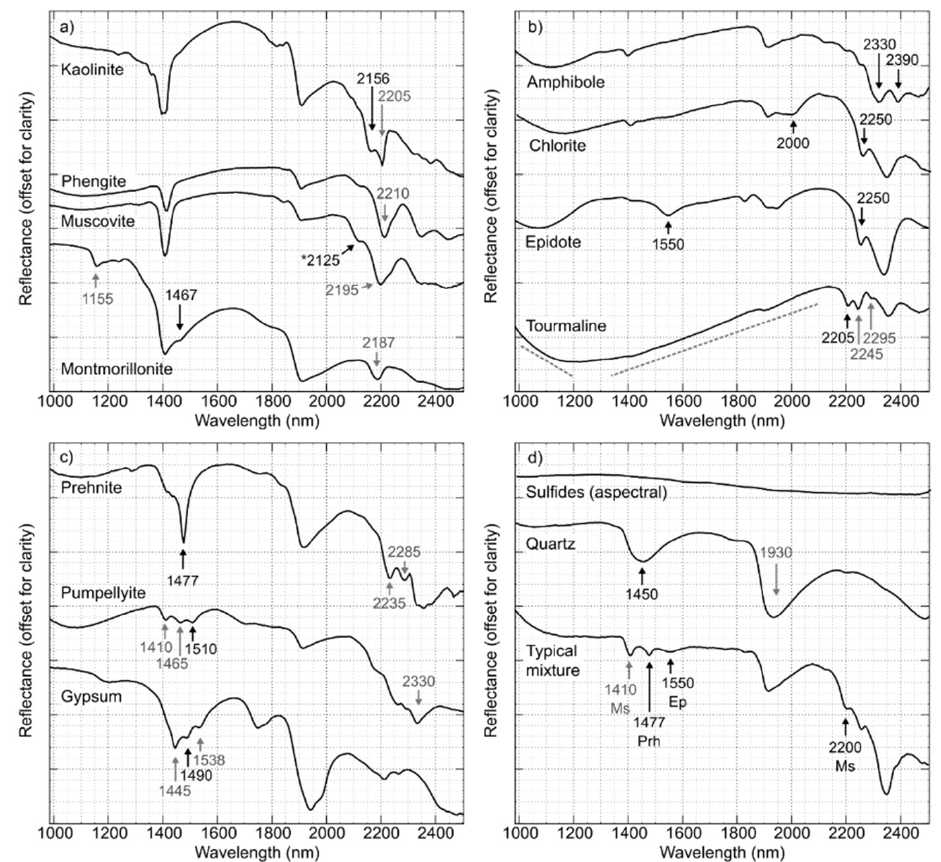
Figure 2. Mineral spectra derived from the sample suite, in all cases obtained from 3 × 3 pixel averages. Absorptions used for identifications are indicated with black arrows, and additional distinctive absorptions (not used here) are indicated in grey. Dashed lines indicate regions where minerals are identified using the slope of the spectrum (band ratios). Spectra are offset and scaled for clarity but are not continuum removed. ( a ) Spectra of Al-bearing phyllosilicates. Note that the 2125 nm absorption of white mica is only detectable in coarse-grained samples. ( b ) Spectra of (Fe, Mg)-bearing minerals. ( c ) Spectra of Ca-bearing minerals. ( d ) Spectra of aspectral minerals (top), and a typical mineral mixture (bottom) occurring in the sample suite, showing prehnite, epidote and white mica within a single